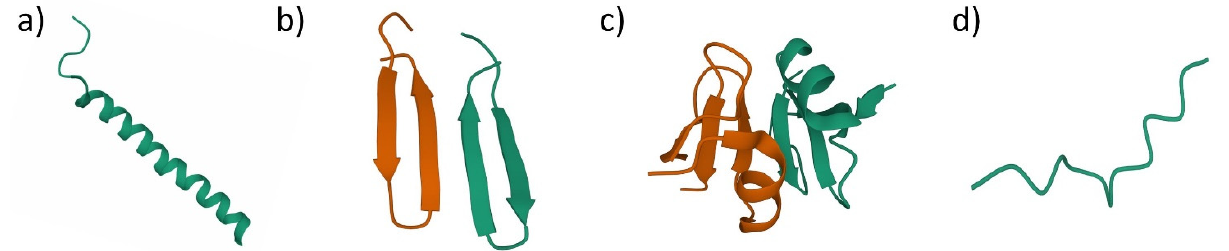
Figure 2. Antimicrobial peptides structural classification based on their secondary structure. ( a ) alpha-helices AMPs, human LL-37 (PDB ID: 2K60); ( b ) beta-sheets AMPs, protegrin-1 (PDB ID: 1ZY6); ( c ) mixed structure AMPs, human beta-defensin-2 (PDB ID: 1FD4); ( d ) extended structure AMPs, indolicidin (PDB ID: 5ZVN).